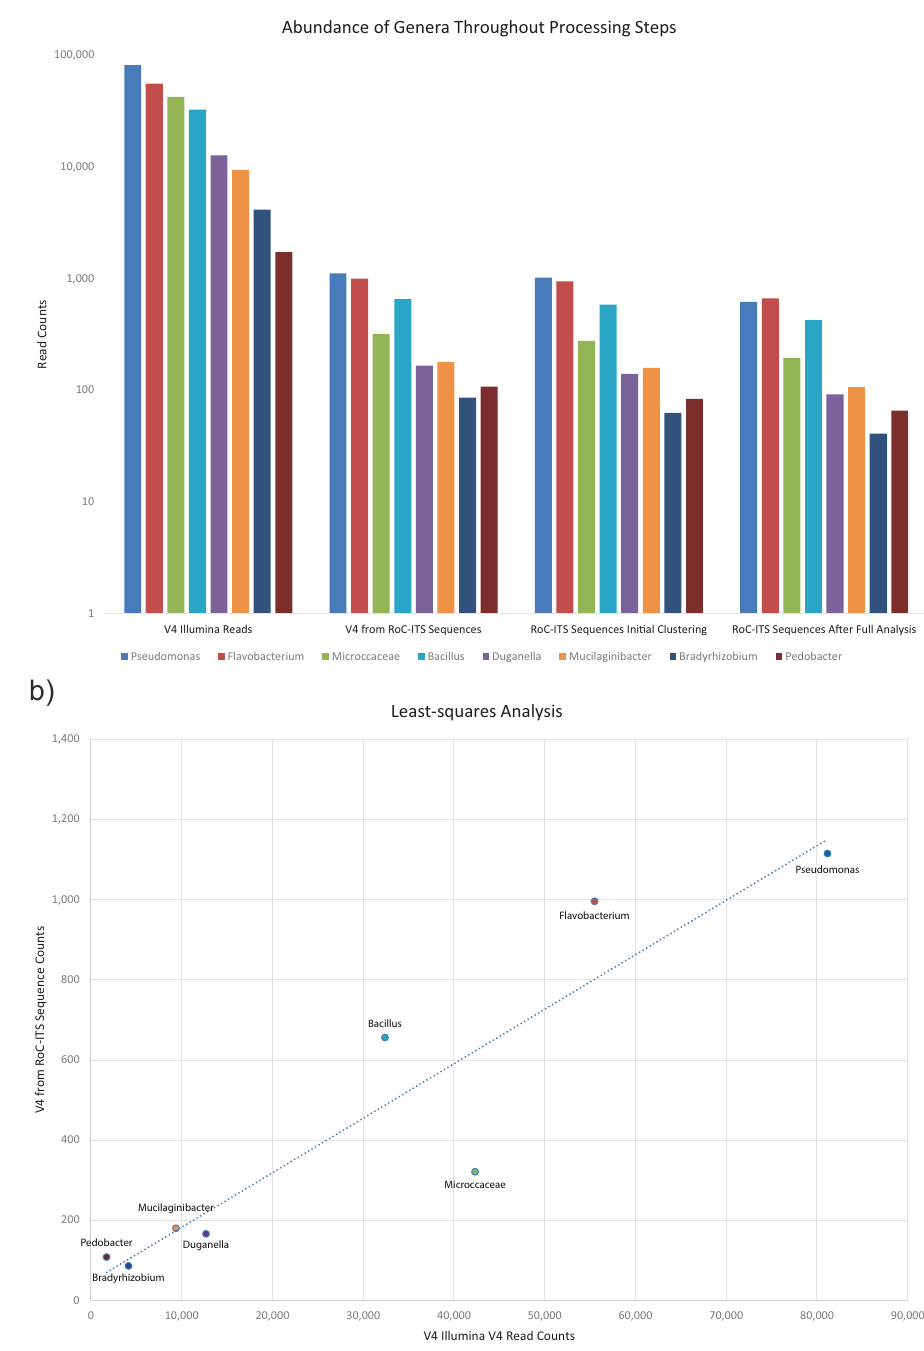
Fig. 3 Comparison of genera abundance. a Genera during different techniques or at different stages of processing: Illumina reads generated from the V4 region, V4 regions identi fi ed on the RoC-ITS sequences, RoC-ITS sequences after the initial clustering to identify genera, and RoC- ITS sequences after being processed fully through the RoC-ITS pipeline to identify high-quality clusters. b Least-squares analysis of RoC-ITS and Illumina V4 data with R 2 value of produced 44 clusters containing fi ve or more 16S sequences per sequence using a combination of the established 16S primers and cluster; these 44 clusters accounted for 3584 of the RoC-ITS reads. sequence similarity (see methods). We were able to isolate the These clusters were initially classi fi ed by the majority genus intact 16S gene in 3628 of the 3667 RoC-ITS sequences. Of these, present in the cluster. The full-length RoC-ITS sequences were 3568 could be assigned to a particular genus based on BLAST grouped into eight genera-speci fi c clusters and then examined using the QIIME V4 consensus sequences (Table 2). These 16S individually in more detail (Table 3). Note that the least abundant segments were then clustered with cd-hit-est at 95% identity and